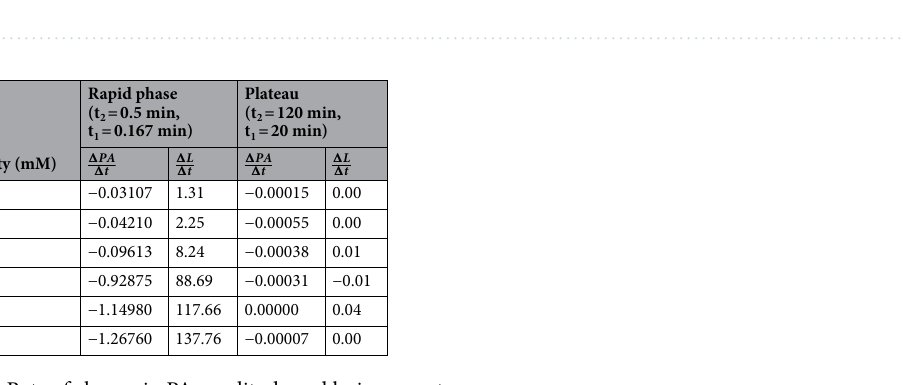
Figure 2. ( a ) Variation in normalized PA amplitude with time for the first 3 min of experimentation, showcasing the rapid phase of biphasic PA amplitude variation roughly till 0.5 min, ( b ) the same for 3 min to 120 min, showing the steady state i.e. the plateau, ( c ) variation in lysis percentage with time for the first 3 min, showing rapid phase within the first 0.5 min, ( d ) plateau of lysis percentage variation with time from 3 to 120 min.